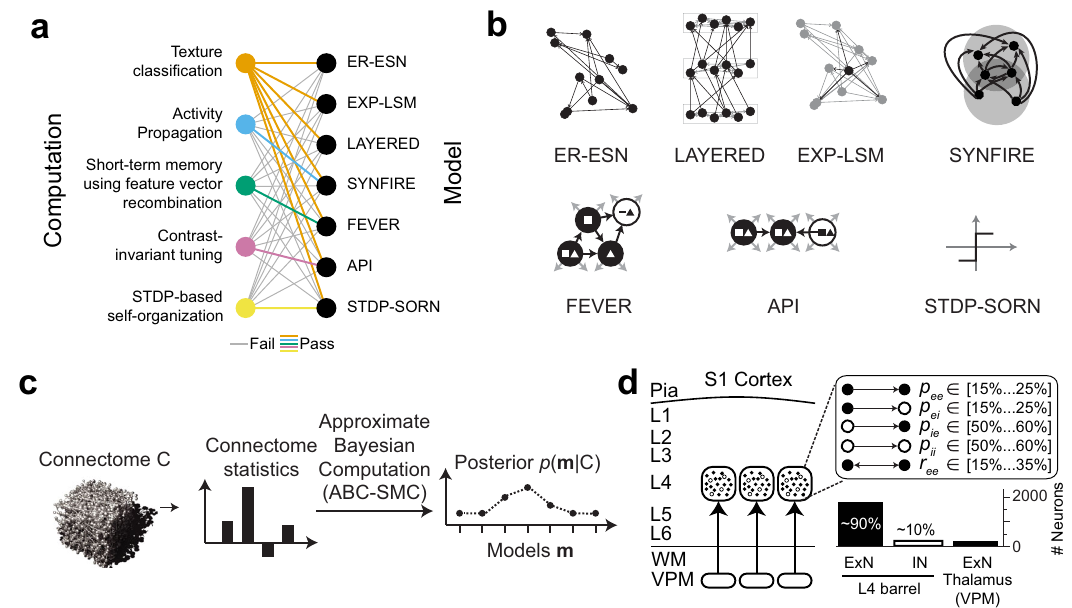
Fig. 1 Relationship between models and possible computations in cortical circuits, and proposed strategy for connectomic model distinction in local circuit modules of the cerebral cortex. a Relationship between computations suggested for local cortical circuits (left) and possible circuit-level implementations (right). Colored lines indicate successful performance in the tested computation; gray lines indicate failure to perform the computation (see Supplementary Fig. 1 for details). b Enumeration of candidate models possibly implemented in a barrel-circuit module. See text for details. c Flowchart of connectomic model selection approach to obtain the posterior p ( m |C) over hypothesized models m given a connectome C. ABC-SMC: approximate Bayesian computation using sequential Monte – Carlo sampling. d Sketch of mouse primary somatosensory cortex with presumed circuit modules ( “ barrels ” ) in cortical input layer 4 (L4). Currently known constraints of pairwise connectivity and cell prevalence of excitatory (ExN) and inhibitory (IN) neurons ( p ee : pairwise excitatory-excitatory connectivity 30 – 33,36 , p ei : pairwise excitatory-inhibitory connectivity 31,33 , p ii : pairwise inhibitory-inhibitory connectivity 31,34 , p ie : pairwise inhibitory-excitatory connectivity 31,33,35 , r ee : pairwise excitatory-excitatory reciprocity 30,31,33